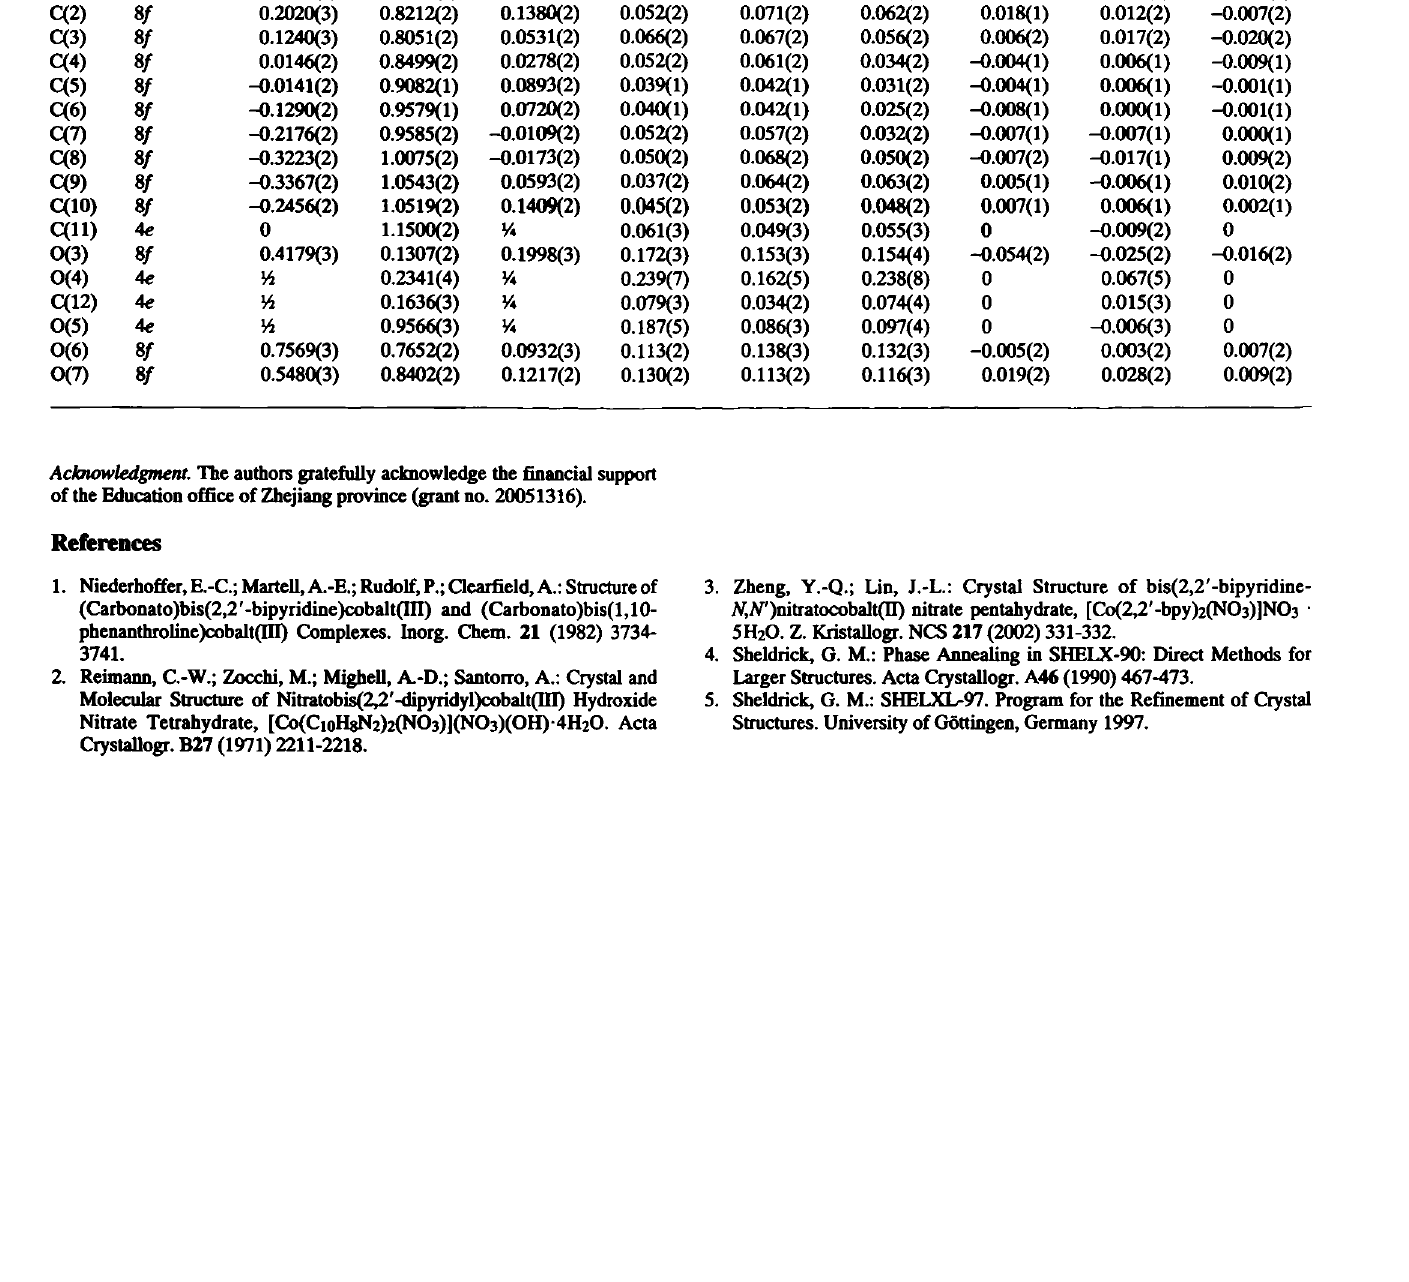
Table 3. Atomic coordinates and displacement parameters (in A 2